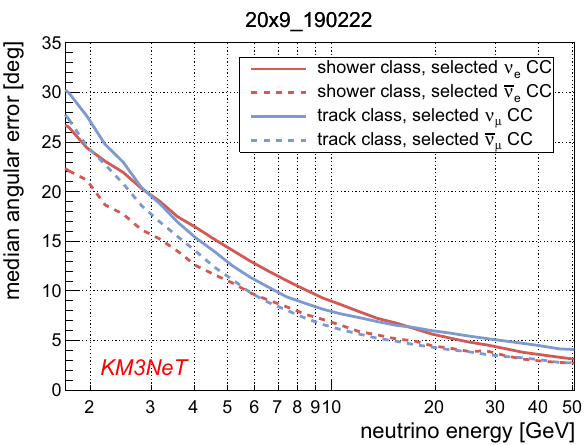
Fig. 3 Mediandirectionresolutionasafunctionoftrueneutrinoenergy E ν forupgoing ν e CCand ν e CCevents classifiedasshower-like aswell as ν μ CC and ν μ CC events classified as track-like. For a definition of shower- and track-like events see Eq.